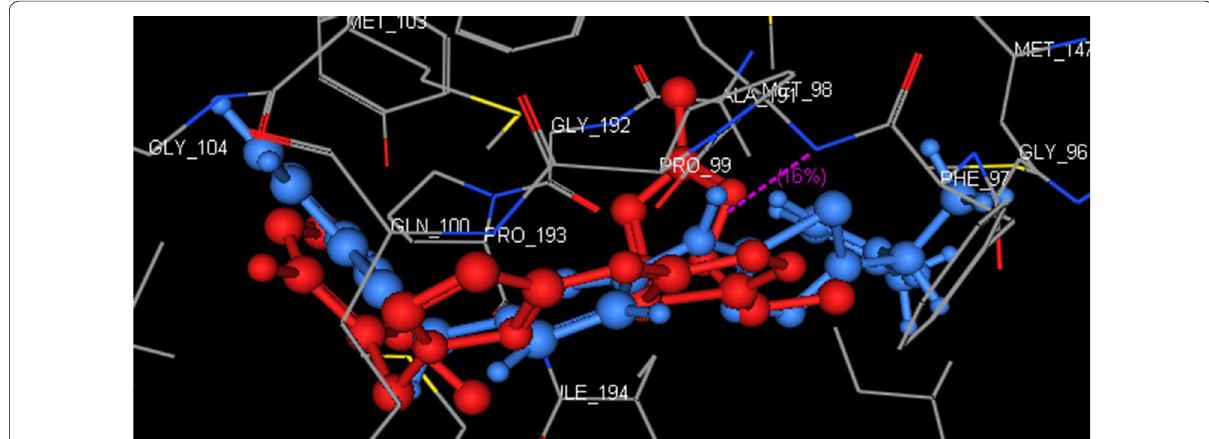
Fig. 2 Superimposition of the co‑crystallized ligand ( red ) and the re‑docked ligand ( blue ) inside the active site of 5JFO